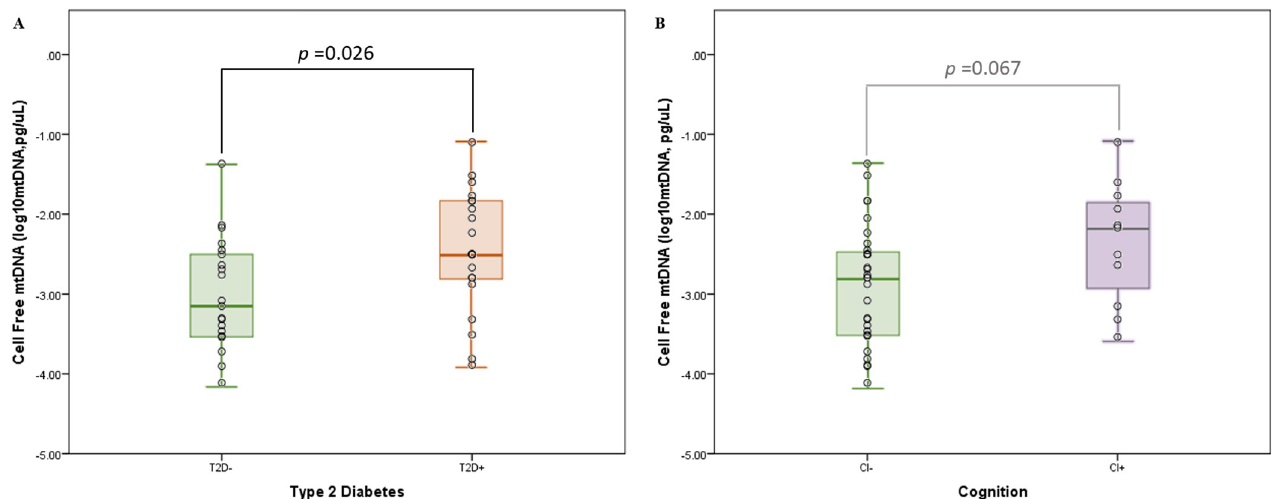
Fig 1. Average cell-free mitochondrial DNA levels stratified on diabetes and cognitive status. (A) Cell-free levels appear to be higher in individuals with diabetes (t-test p-value, 0.026) and those with cognitive impairment (B) (t-test p-value = 0.067, insignificant). A larger effect was observed for diabetic individuals. Note, age is matched between the T2D stratified analysis, but is not matched in the CI stratified analysis (i.e., CI+ subjects are older than CI-).